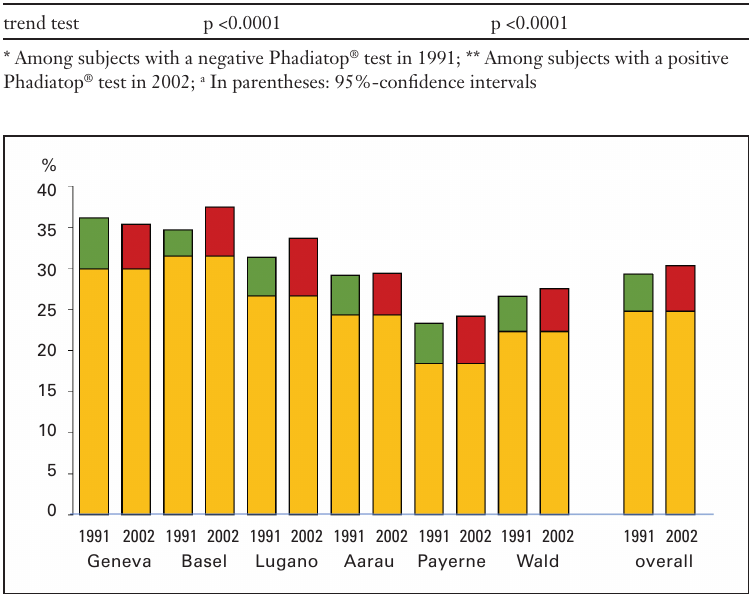
Figure 1 Rates of sensitisation to Phadiatop ® in the two surveys (1991 and 2002). Yellow segments: Phadiatop ® positive in both surveys; green segments: converters from positive to negative; red segments: converters from negative to